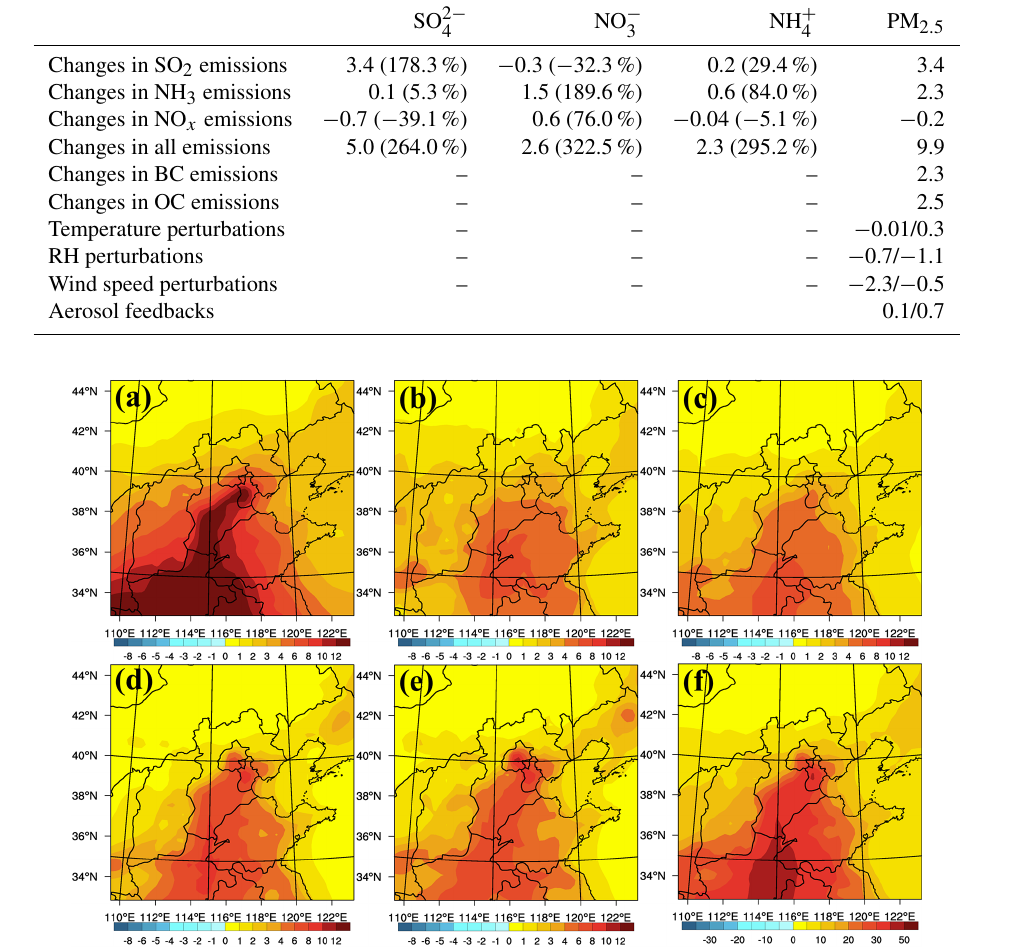
Figure 3. Predicted monthly mean changes of sulfate (a) , nitrate (b) , ammonium (c) , BC (d) , OC (e) , and PM 2 . 5 (f) due to emission changes from 1960 to